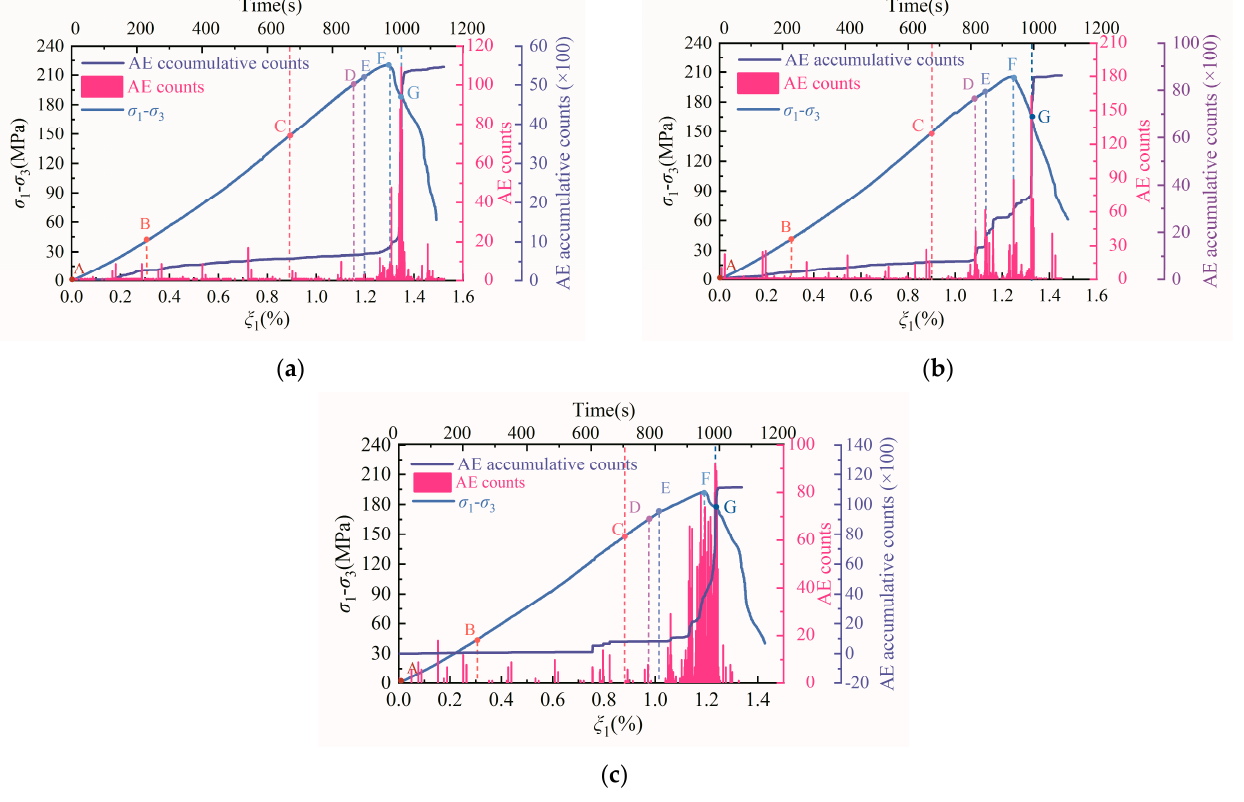
Figure 10. Evolution curves of AE counts and cumulative AE counts for diorite under different unloading confining-pressure rates: ( a ) 0.008 MPa·s − 1 , ( b ) 0.016 MPa·s − 1 , and ( c ) 0.032 MPa·s − 1 . Note: The meaning of A–G in the above figures is the same as that of A–G in Figure 5 and Figure 7.